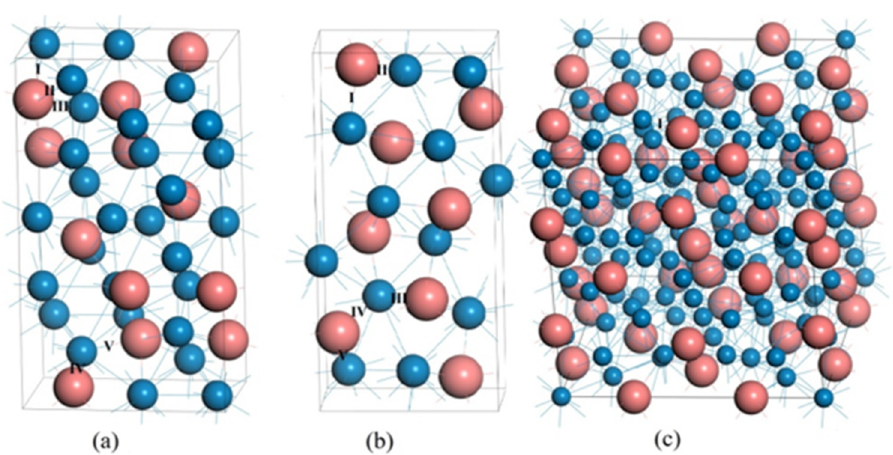
Figure 1. The crystal structure of ( a ) Cr 7 C 3 , ( b ) Cr 3 C 2 and ( c ) Cr 23 C 6 .